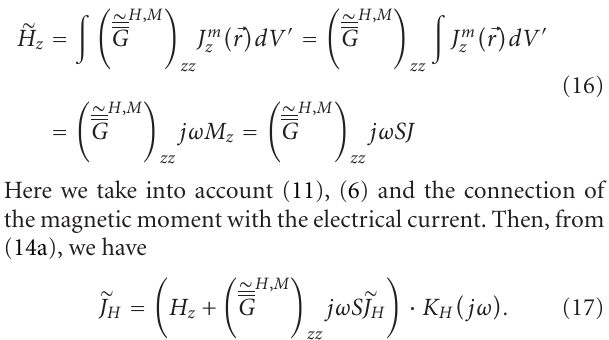
Figure 5: Excitation of the internal dipole antenna through small